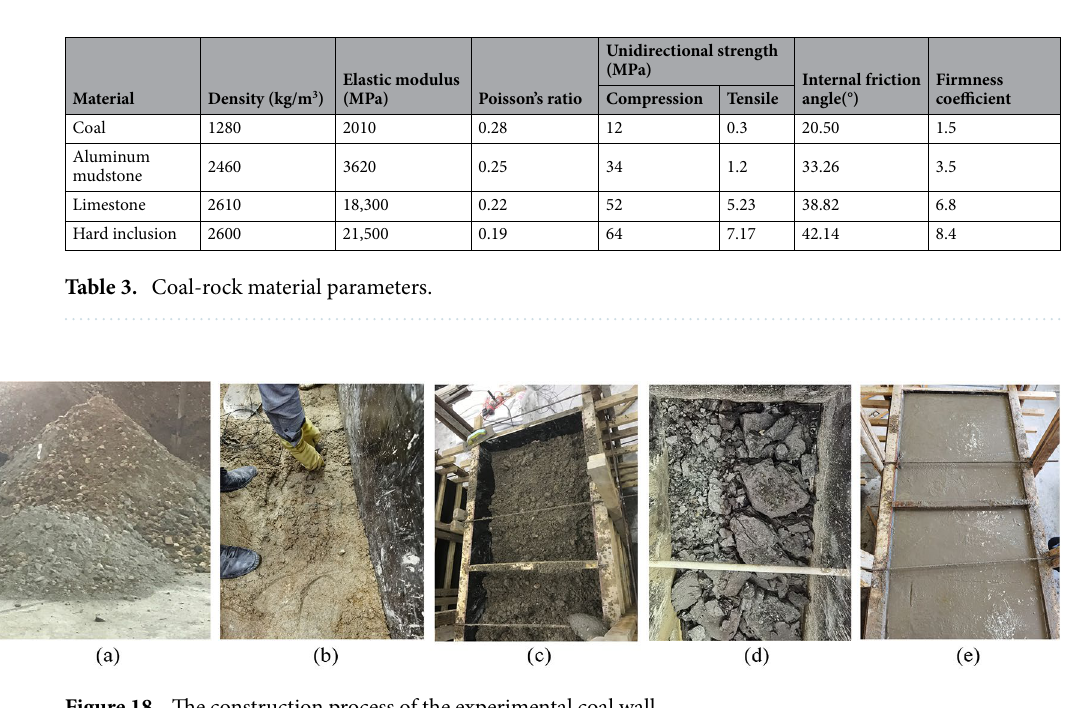
Figure 18. The construction process of the experimental coal wall.